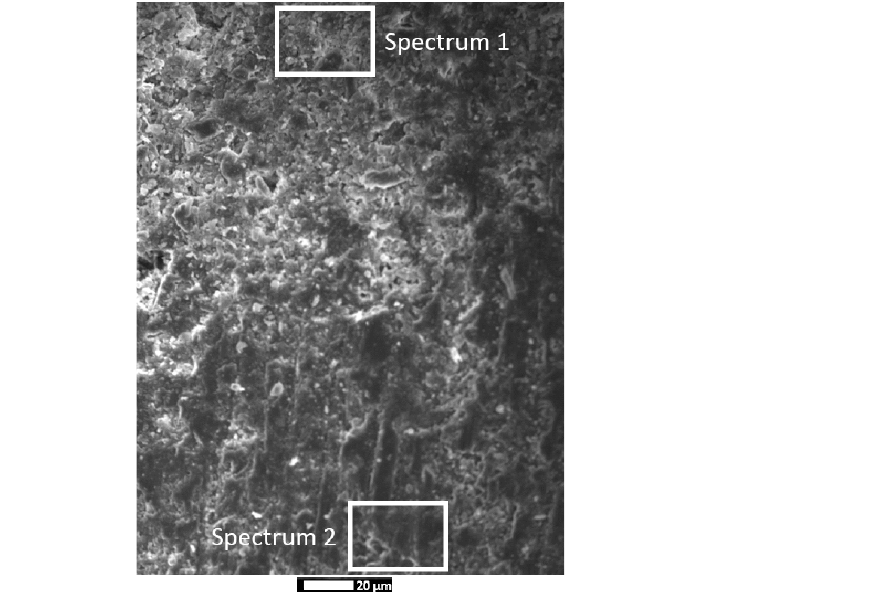
Figure 3. SEM micrograph of the coating-concrete interface, showing the respective energy-dispersive X-ray spectroscopy (EDS) spectral areas. Table 4. EDS spectra of the coating and of the concrete, as presented in Figure 3.